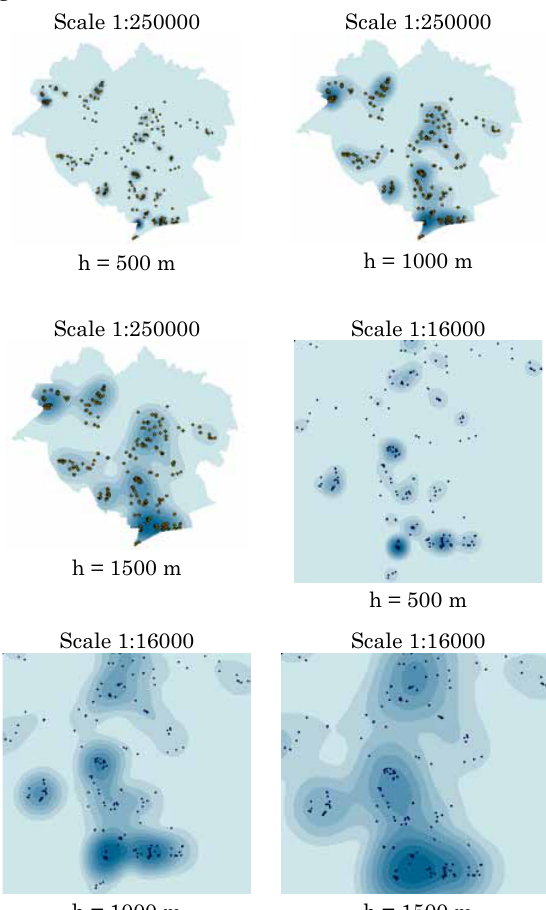
Fig. 3. Analysis of kernel function density distribution for 2004 Source : own study.